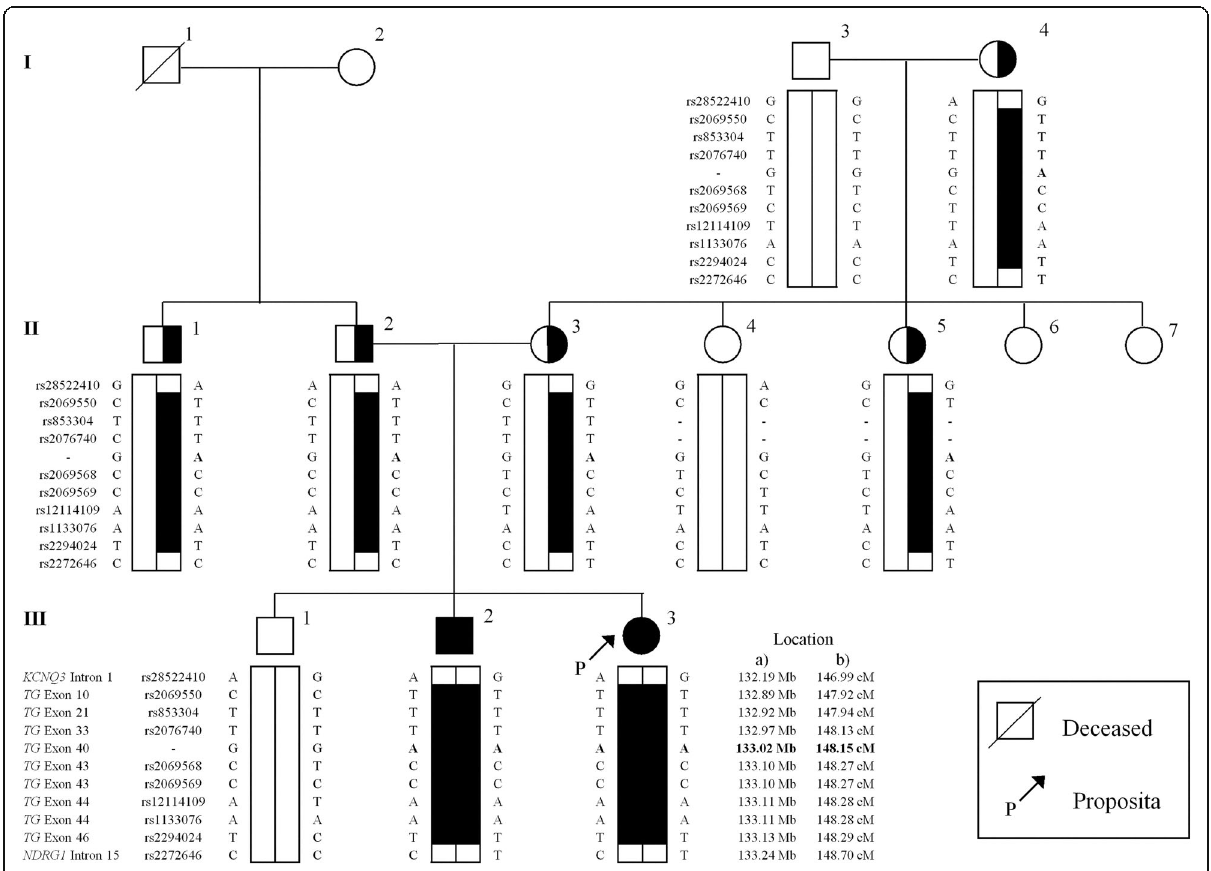
Fig. 5 Haplotypes present in the family members using single nucleotide polymorphic markers. Black filled, semi-round or semi-square and open symbols indicate affected individuals, unaffected carriers and wild type, respectively. The inherited portion of the disease associated haplotype is indicated in blackened bar. a) Marker location on the human genome reference sequence (NCBI Build 38). b) Marker location on the international HapMap